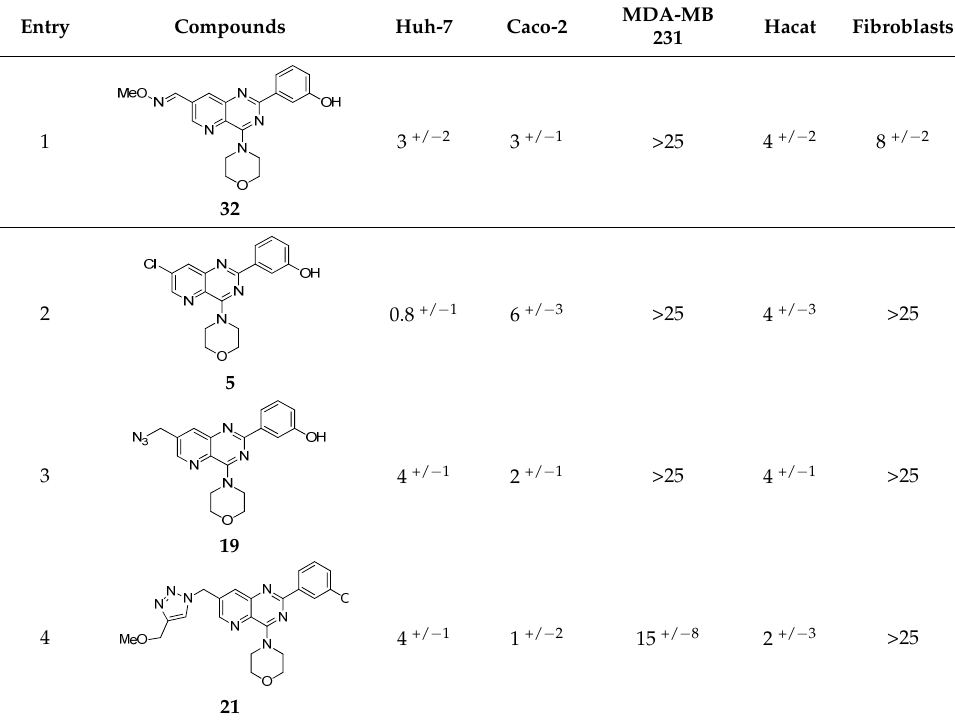
Figure 5. Binding modes from docking for compounds 6 (pink), 19 (orange) and 32 (green) in PI3K α ( left ) and mTOR ( right ).